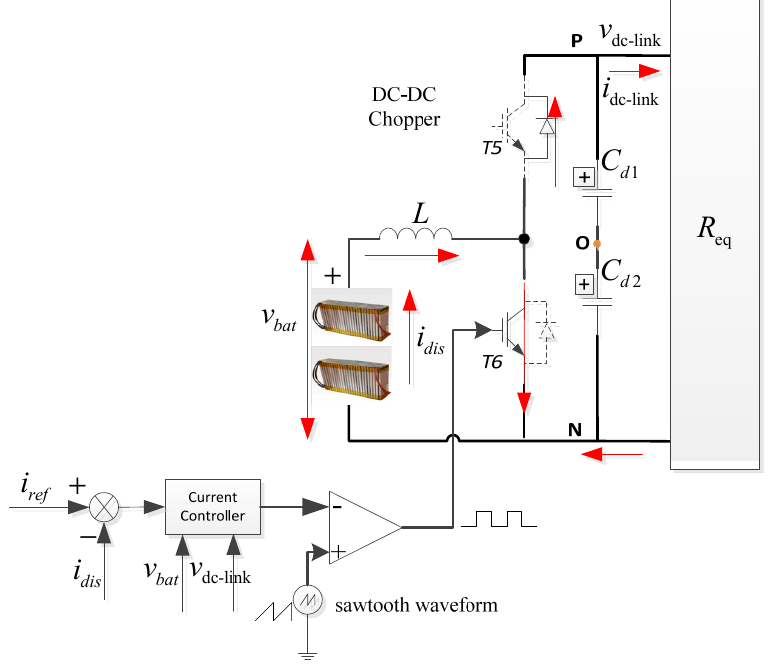
Figure 2. Control strategy of the DC-DC boost chopper in discharging